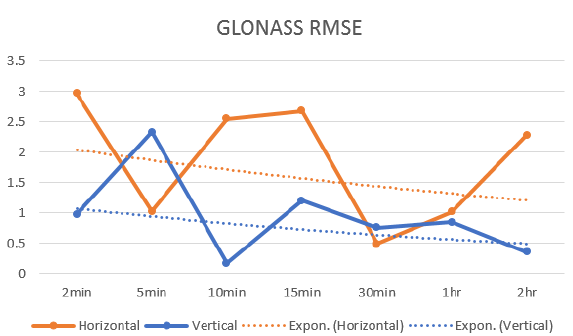
Figure 15. RMSE of horizontal and vertical observations using GPS and Glonass satellites. Y-axis in